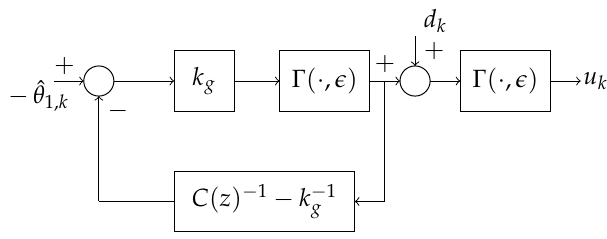
Figure 2. Proportional-integral ESC with quantized